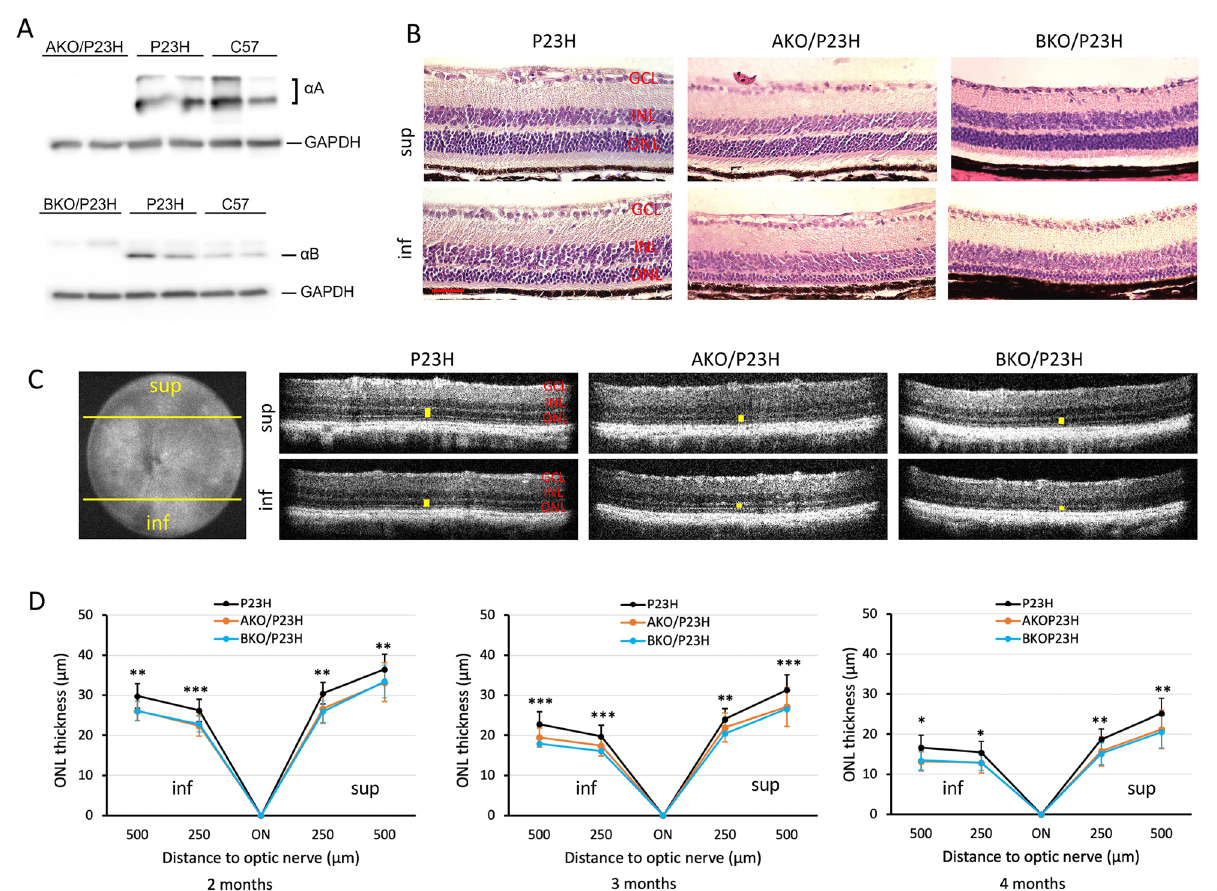
Figure 1. Increased photoreceptor loss in AKO/P23H and BKO/P23H mouse retina compared with age matched P23H controls. ( A ) Representative images of immunoblots probing for α A-crystallin ( α A) or α B-crystallin ( α B) from whole retinal lysates of AKO/P23H or BKO/P23H, P23H, and C57 confirm the loss of these proteins in the respective strains. ( B ) Representative H&E staining images of superior (sup) and inferior (inf) retina at the age of 4 months in AKO/P23H, BKO/P23H, and control P23H mice show increase loss of photoreceptors in the former compared to the control. ( C ) Representative optical coherence tomography (OCT) images of superior and inferior retina of 4-month-old AKO/P23H, BKO/P23H, and P23H mice correspond to the histology findings in panel B. ( D ) Quantification of the thickness of the outer nuclear layer (indicated by yellow bars in the OCT images) of superior and inferior retina measured at both 250 and 500 µm from the optic nerve head by OCT in AKO/P23H, BKO/P23H, and P23H mice at the age of 2, 3, and 4 months. Scale bar: 50 µm. (n ≥ 16), * p < 0.05; ** p < 0.01; *** p < 0.001; One-way ANOVA. GCL, ganglion cell layer; INL, inner nuclear layer; ONL, outer nuclear layer; RPE, retinal pigment epithelium.